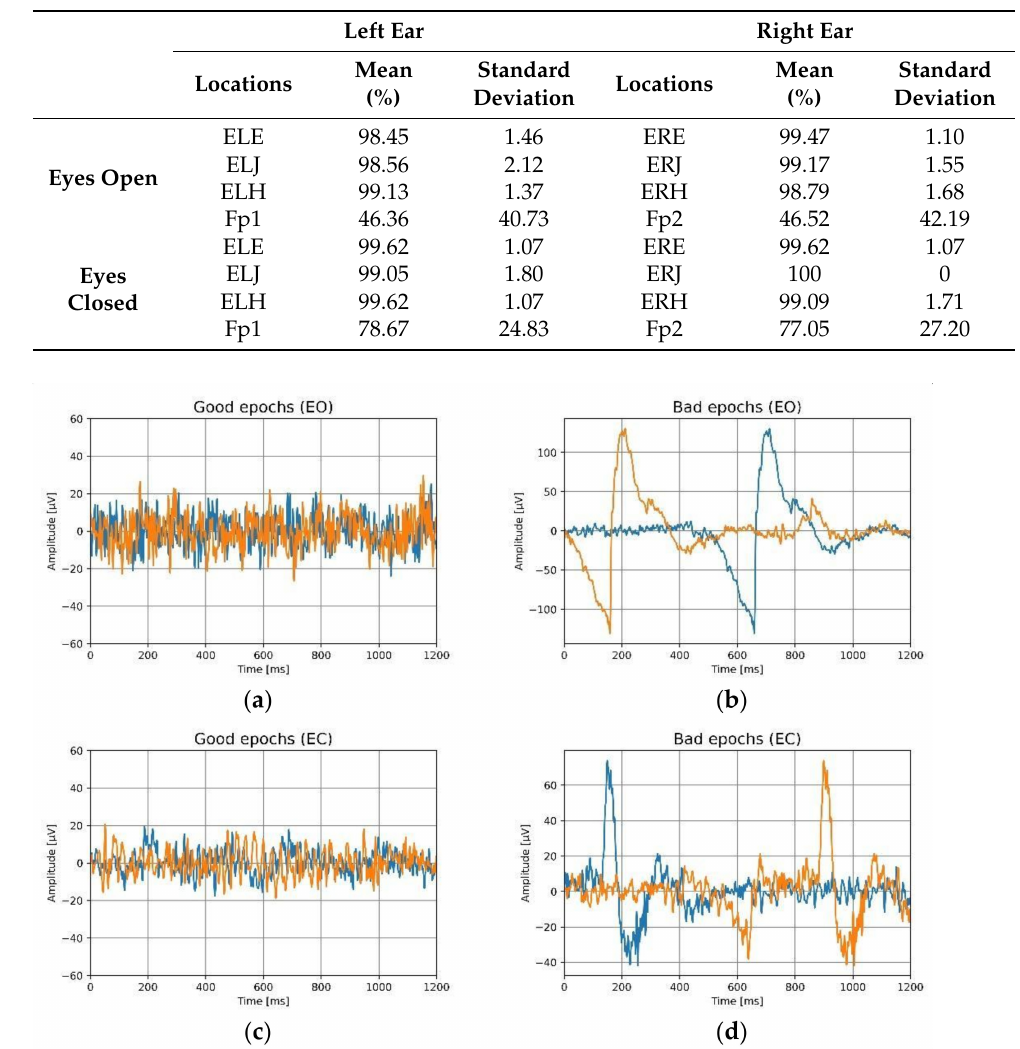
Figure 11. For eyes-open (EO) and the eyes-closed (EC) conditions, the epochs of the ear electrodes are shown. Two distinct epochs are indicated by two distinct colors, ( a ) good epochs for eyes-open, ( b ) bad epochs for eyes-open, ( c ) good epochs for eyes-closed, ( d ) bad epochs for